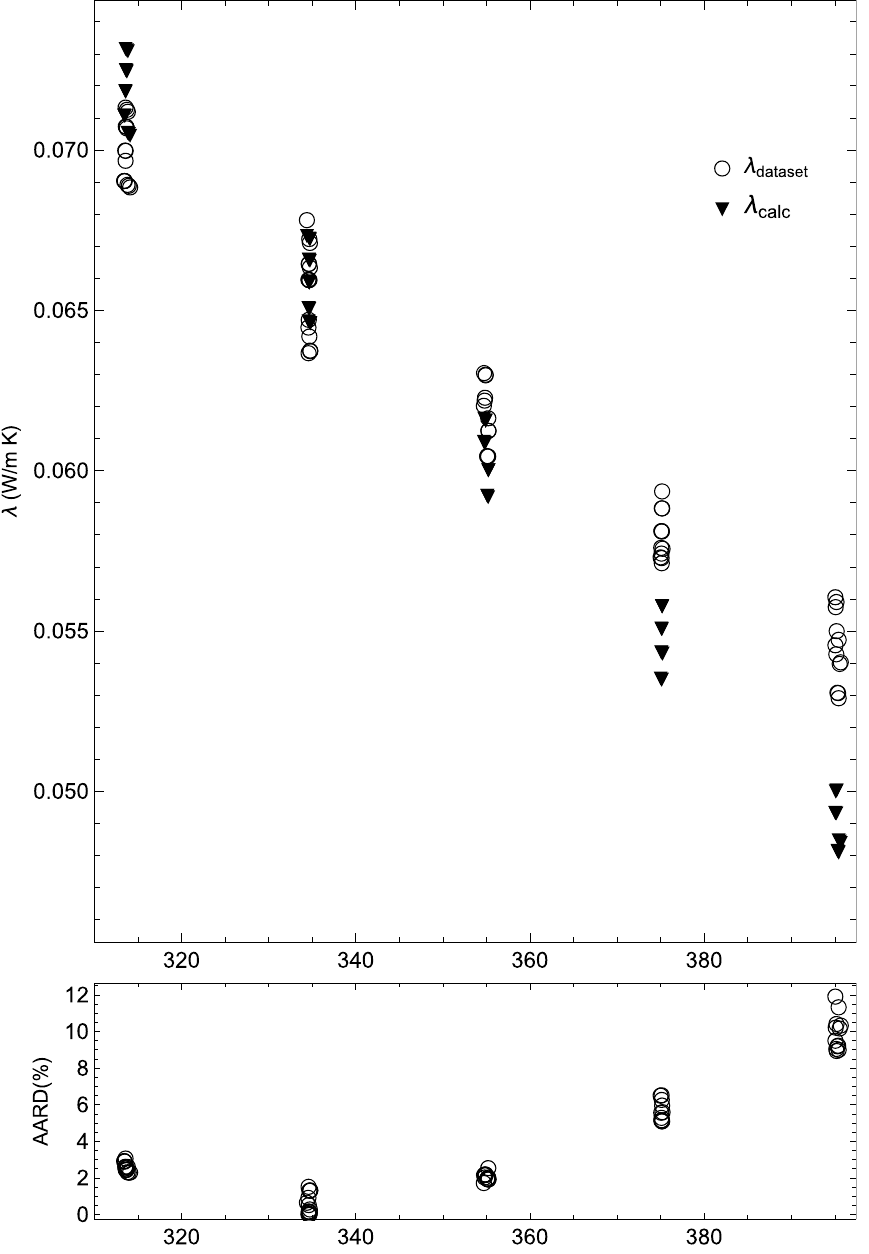
Figure 4. Deviation plot of the fluid R1336mzz(Z) as a function of temperature.